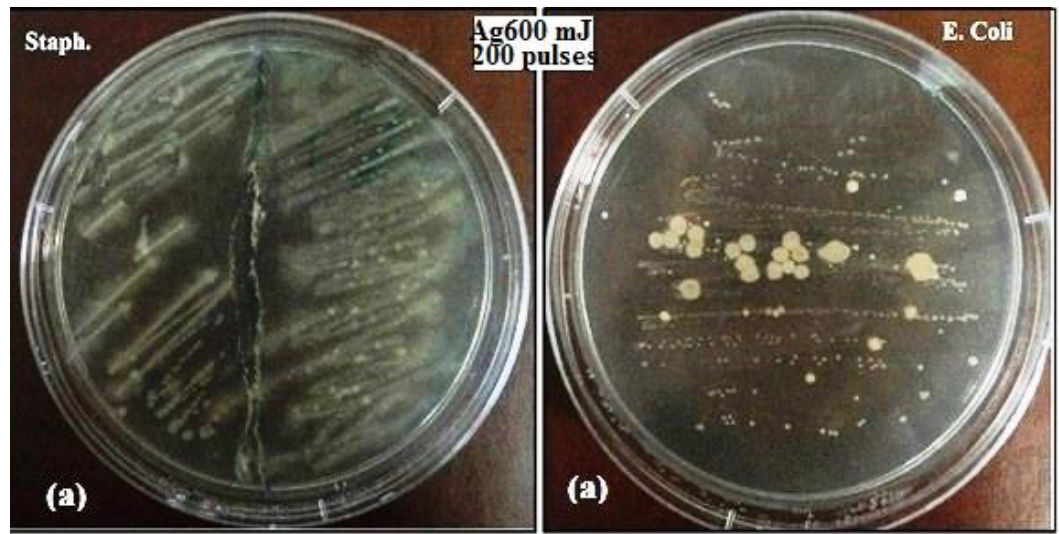
Fig.7: Killing ratio bacteria with (Ag) with energy (600)mJ with (200)pulses partial kill for staph and